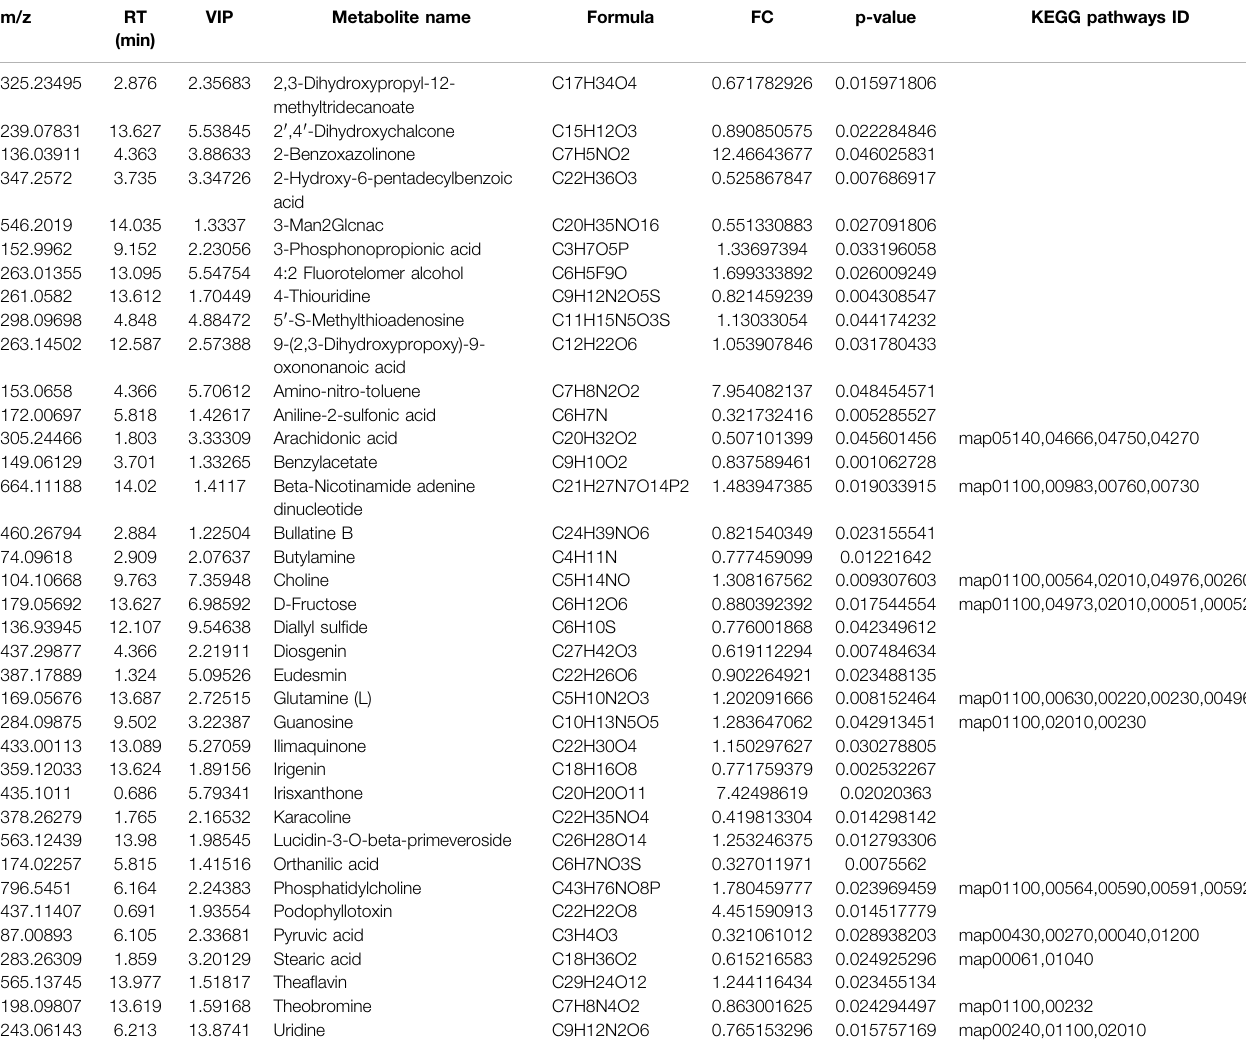
TABLE 2 | Signi fi cant metabolites and related